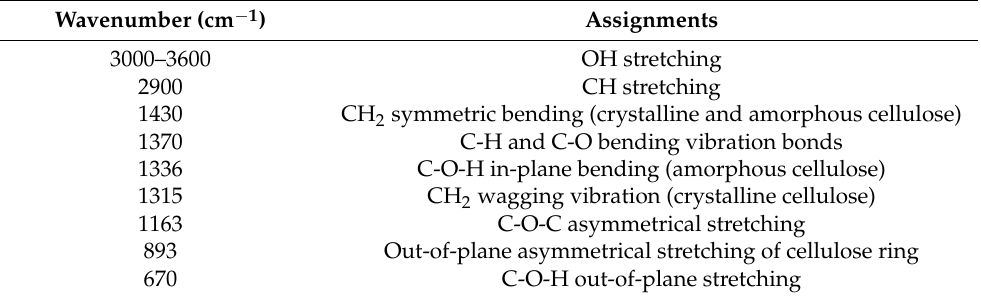
Figure 2. Cellulose FTIR spectra of Asparagaceae species. Table 6. Cellulose peaks of Asparagaceae species.